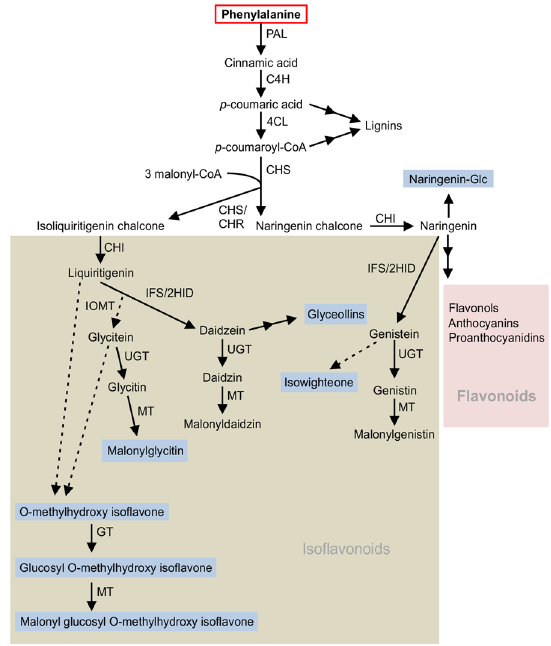
Fig. 4 Overexpression of GmMYB176 – GmbZIP5 upregulates iso fl avonoid biosynthesis. Multiple arrows indicate multiple steps in the pathway and dotted arrows indicate speculated steps. PAL phenylalanine ammonia- lyase, C4H cinnamate-4-hydroxylate, 4CL 4-coumarate-CoA-ligase, CHS chalcone synthase, CHR chalcone reductase, CHI chalcone isomerase, IFS 2-hydroxyiso fl avanone synthase, 2HID 2-hydroxyiso fl avanone dehydratase, IOMT iso fl avone O-methyltransferase, UGT uridine diphosphate glycosyltransferase, MT malonyltransferase. This pathway is adopted and modi fi ed 20 . The blue highlighted metabolites are accumulated at higher level in GmMYB176 – GmbZIP5 overexpression lines compared to